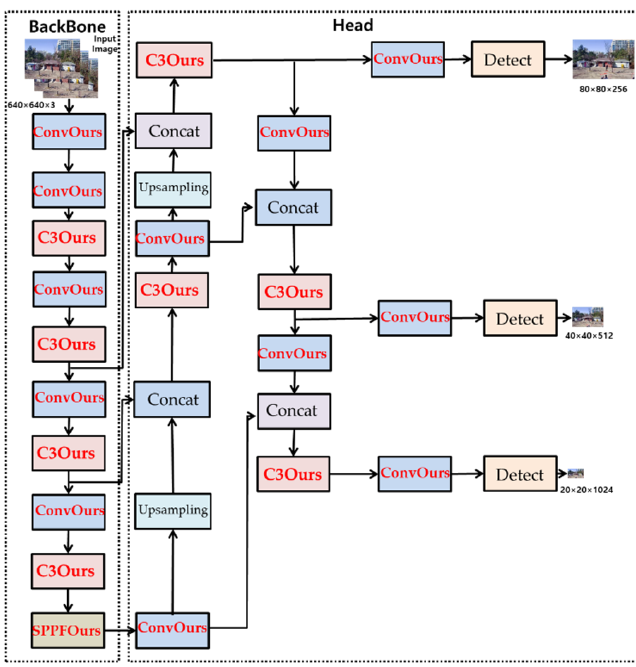
Figure 7. Structure of YOLOv5_Ours (the way we suggest it).